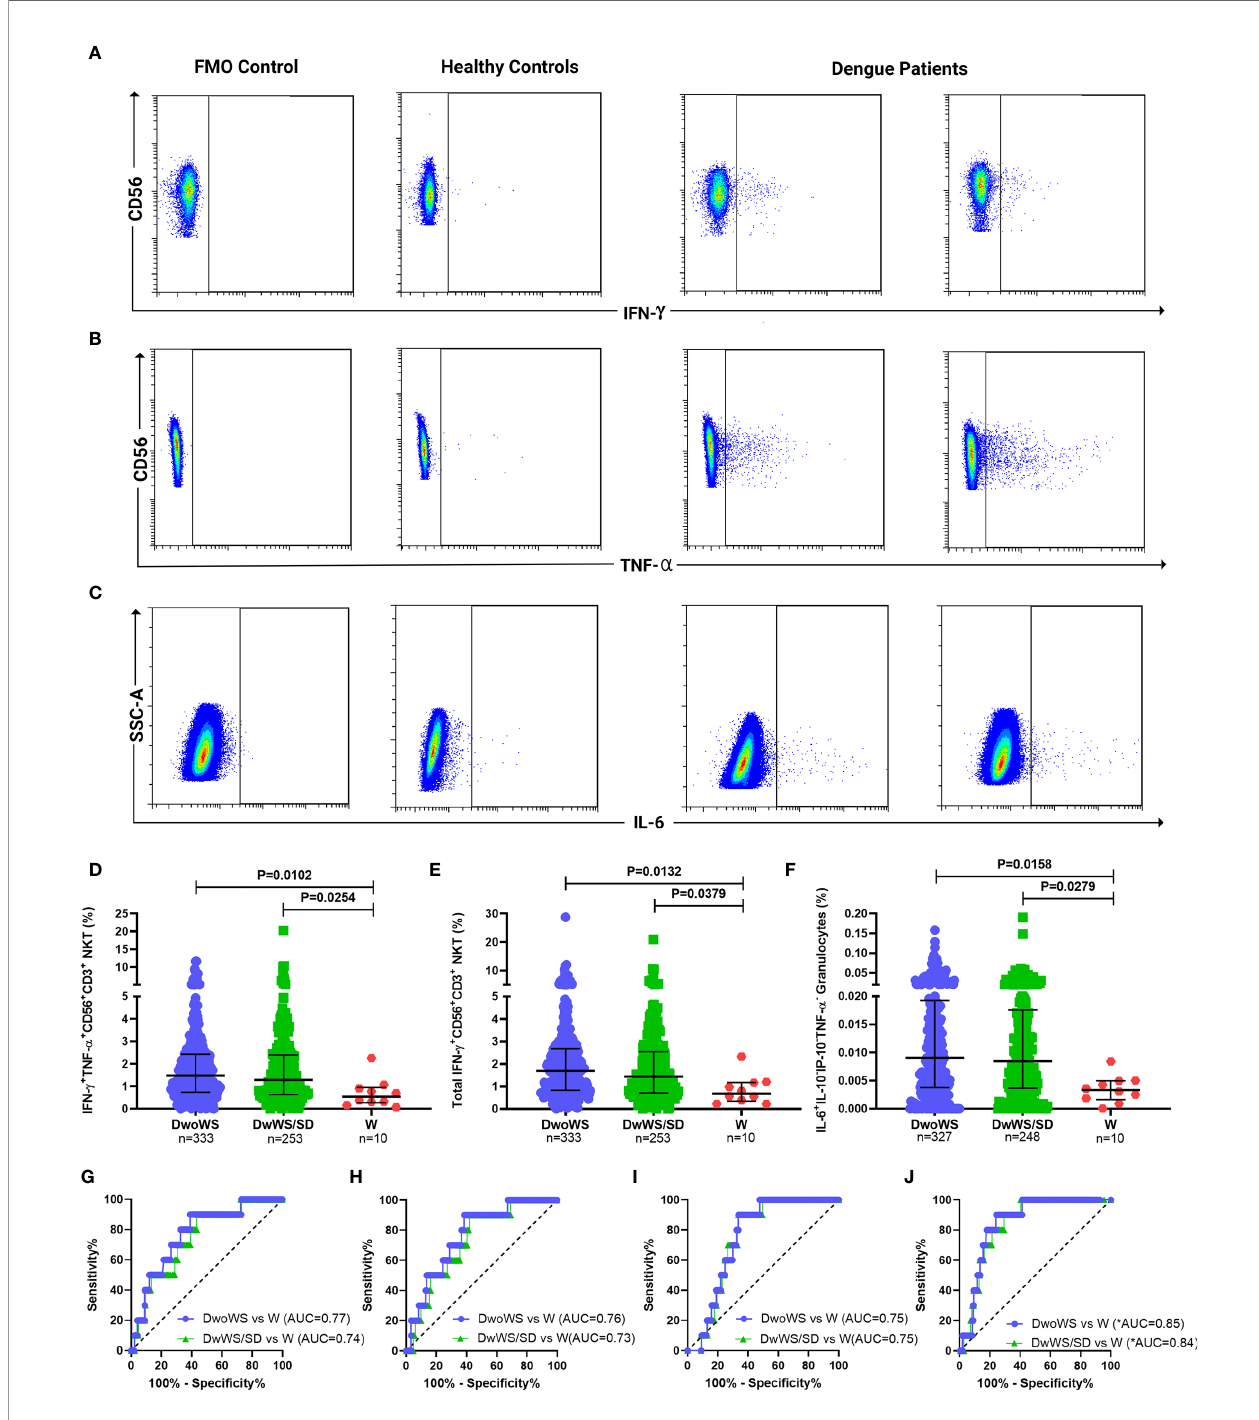
FIGURE 6 | Innate cytokine-secreting cells predicted outcome in dengue patients. Pseudo color fl ow cytometry plots for representative patients displaying FMO control, healthy control, and dengue patient samples for secretion of (A) IFN- g from CD56 + CD3 + NKT cells, (B) TNF- a from CD56 + CD3 + NKT cells, and (C) IL-6 from granulocytes. Frequency of (D) IFN- g + TNF- a + CD56 + CD3 + NKT cells, (E) total IFN- g + CD56 + CD3 + NKT cells and (F) monofunctional IL-6 + granulocytes compared between DwoWS (circle), DwWS/SD (square), and worsened (W; triangle) patients. P-value with median and IQR reported. ROC curve of (G) IFN- g + TNF- a + CD56 + CD3 + NKT cells, (H) total IFN- g + CD56 + CD3 + NKT cells (I) monofunctional IL-6 + granulocytes and (J) composite ROC curve for total IFN- g + CD56 + CD3 + NKT cells combined with monofunctional IL-6 + granulocytes compared between DwoWS (purple) or DwWS/SD (green) and worsened patients. *AUC, composite